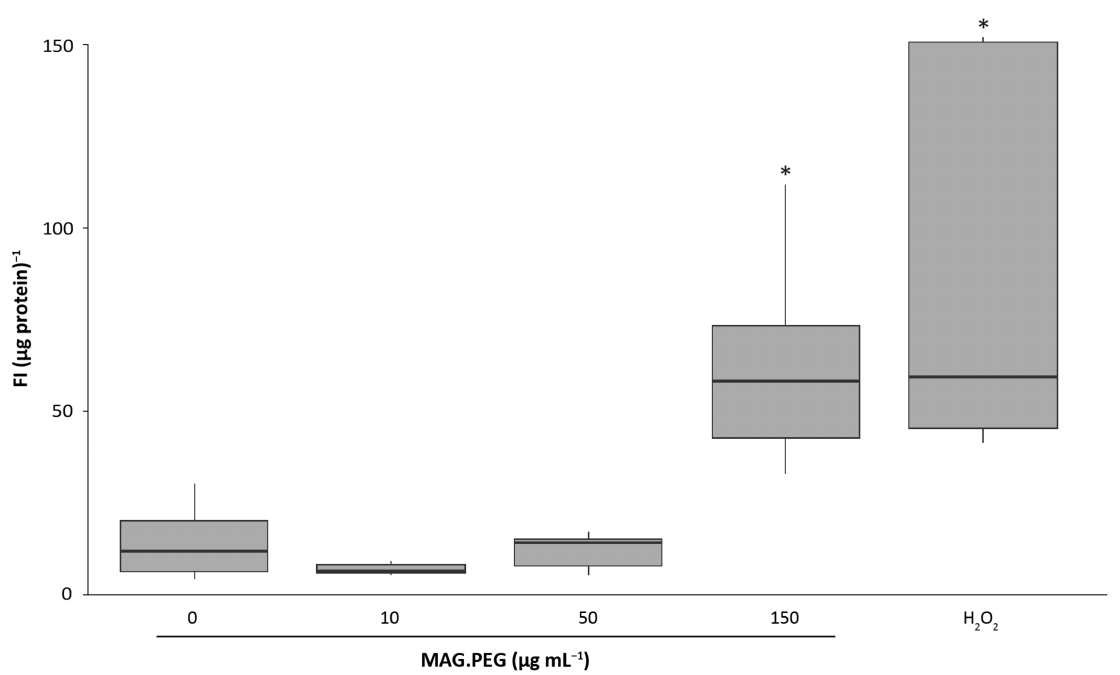
Figure 5. Detection of ROS . The vGPCR cells were cultured in 48-well plates and incubated with MAG.PEG (10, 50 and 150 µ g mL − 1 ) for 24 h or 0.5 mM H 2 O 2 for 45 min as positive control. Then, 10 µ M of DCFDA was added to the medium as described in the Methods section and then the fluorescence was measured in a microplate reader. The fluorescence intensity (FI) of each condition was normalized by the total protein content and represented in a box plot. Kruskal–Wallis followed by the Mann–Whitney U test was performed, and the statistically significant differences between control and MAG.PEG conditions are indicated as * p < 0.05. N =